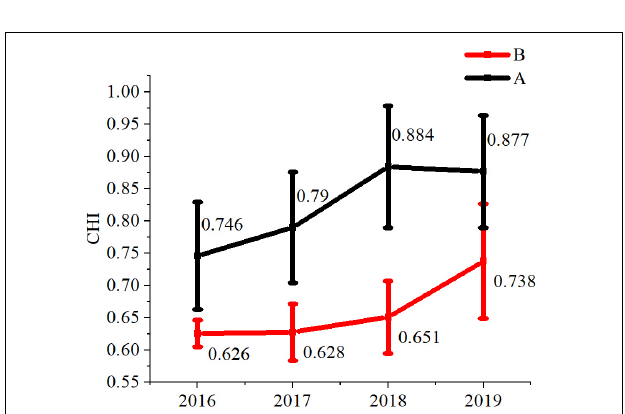
FIGURE 9 | The red trend line indicates the health evaluation results of the ordinary PSR model. The black trend line represents the health evaluation results of the PSR-BP neural network model.